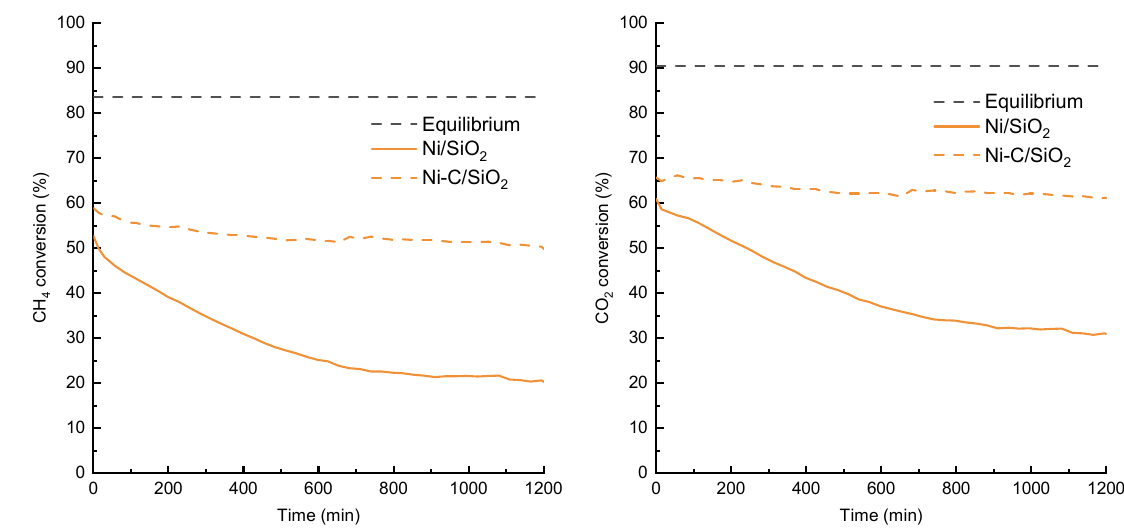
Figure 9. CH 4 and CO 2 conversion during the stability test of Ni/SiO 2 and Ni-C/SiO 2 at 750 °C.